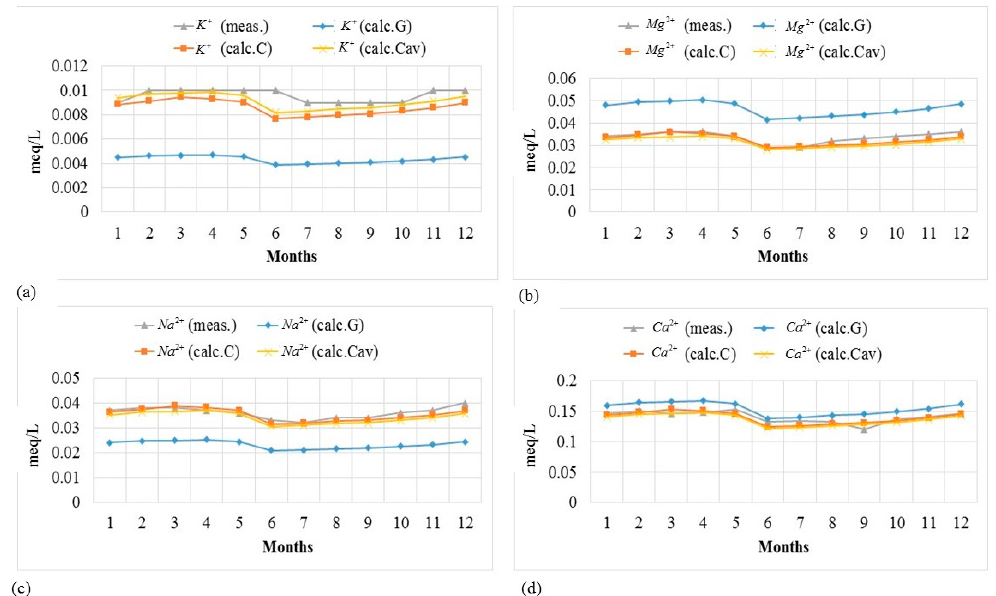
Figure 4 . Measured values (meas.) of the concentration of positive ions and values estimated by the model (calc.) at Slagnäs Station in Skellefte älv, Sweden (January to December 2010). Notation: G = General, C = Customized using one month to calibrate, Cav = Customized using the average of one year to calibrate. ( a ) concentration of potassium ( K + ); ( b ) concentration of Magnesium ( Mg 2+ ); ( c ) concentration of sodium ( Na + ); and ( d ) concentration of calcium ( Ca 2+ ).